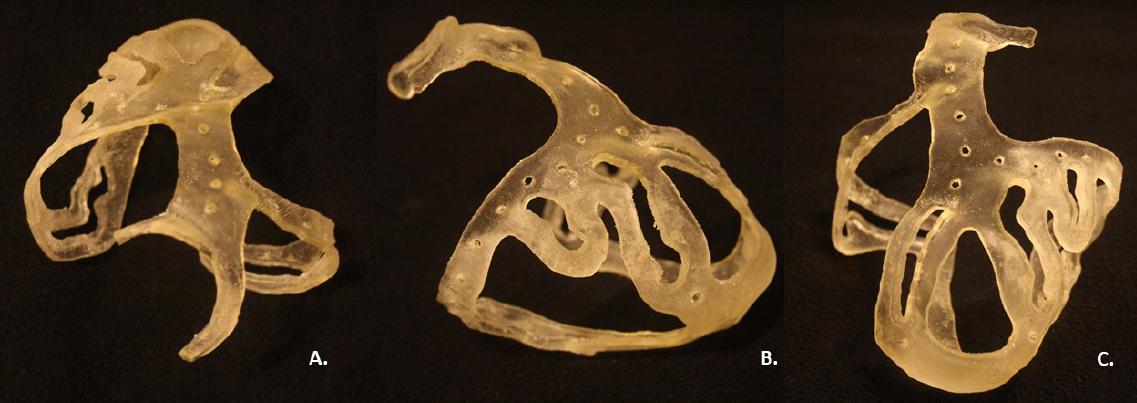
Figure 6. Printed and cleaned surgical guide: ( A ) Above view; ( B ) Left lateral view; ( C ) Frontal view.